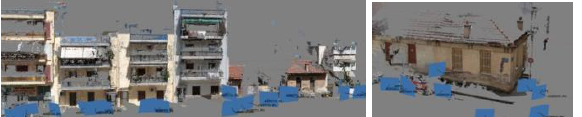
Figure 4. Dense point clouds of sides of an urban block